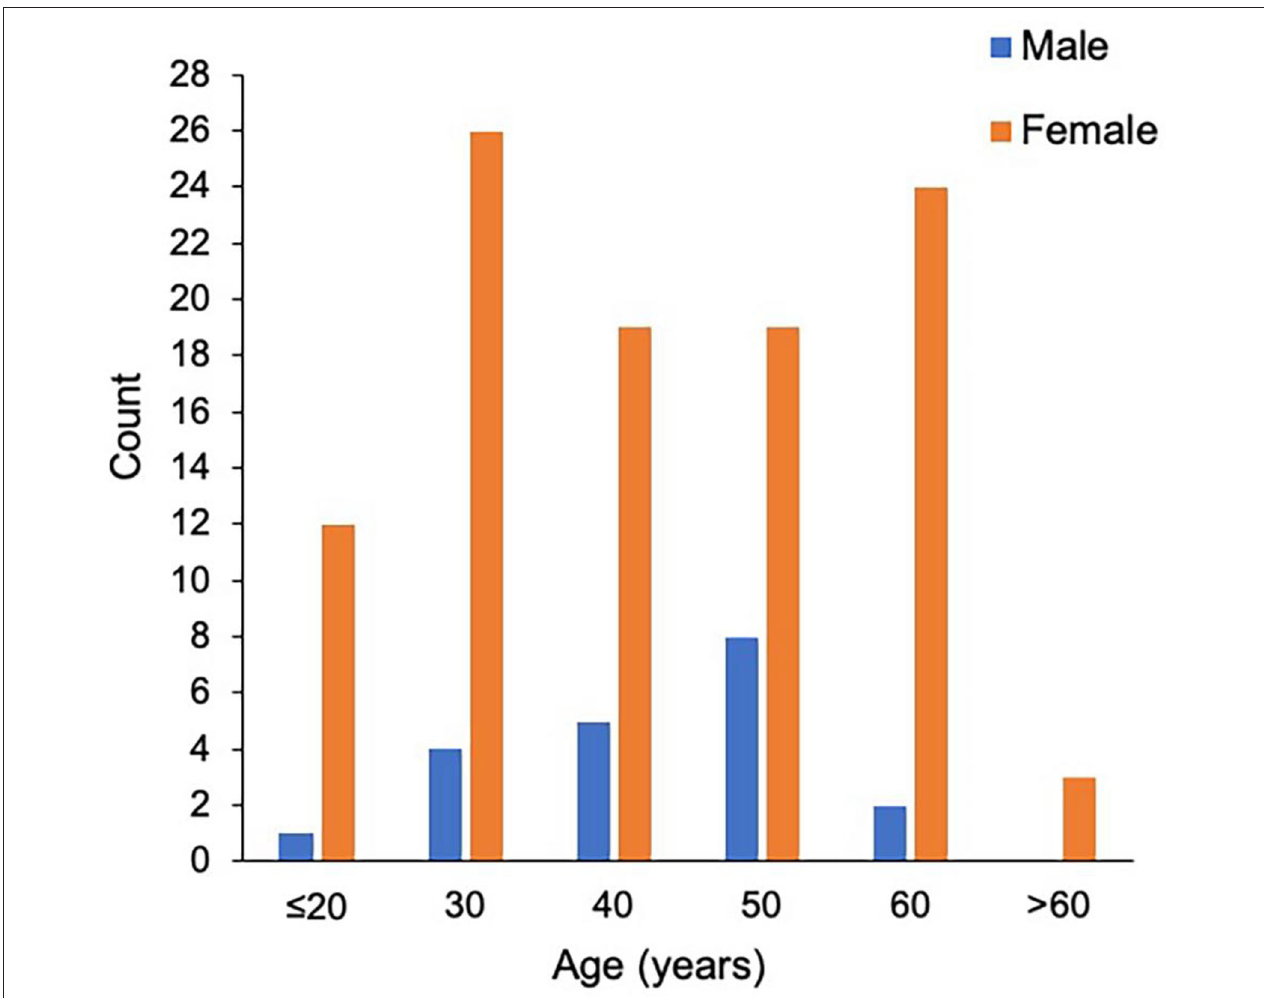
FIGURE 1 | The distribution of age at onset in male and female patients with